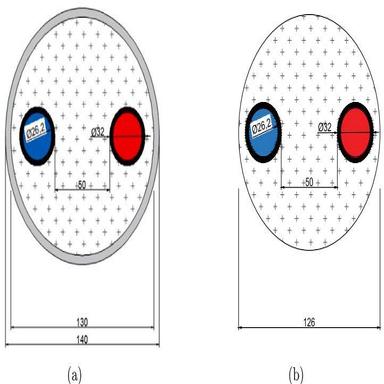
Section of the borehole with (a) 140 mm diameter (b) 126 mm diameter.